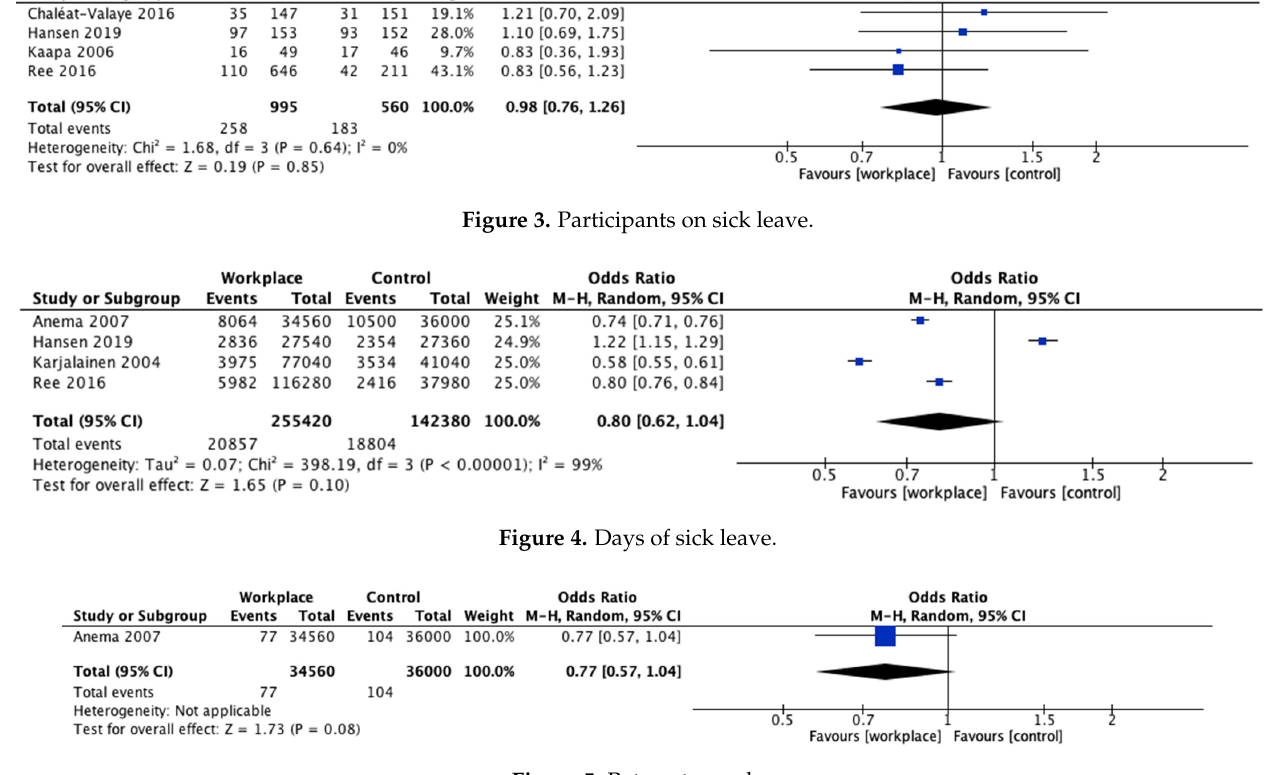
Figure 5. Return to work.